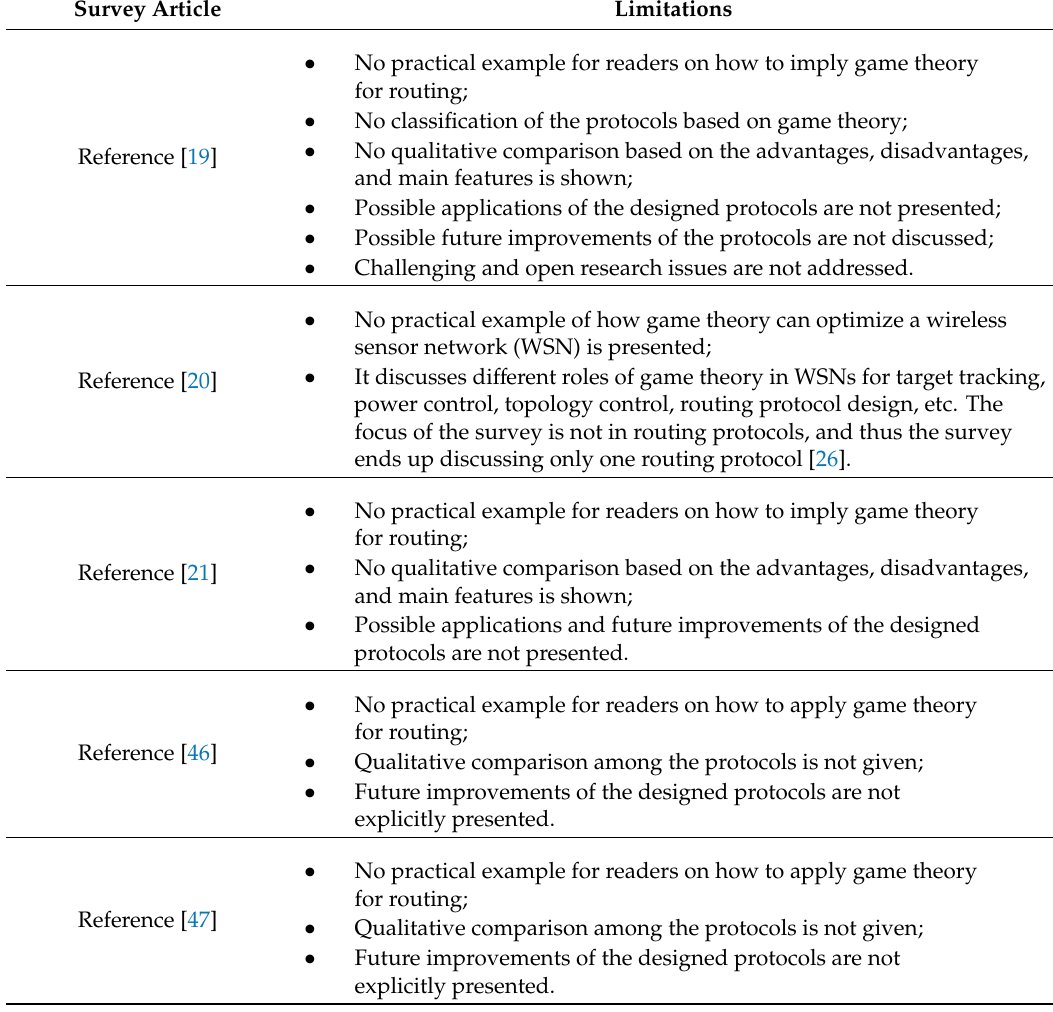
Table 1. Limitations of existing